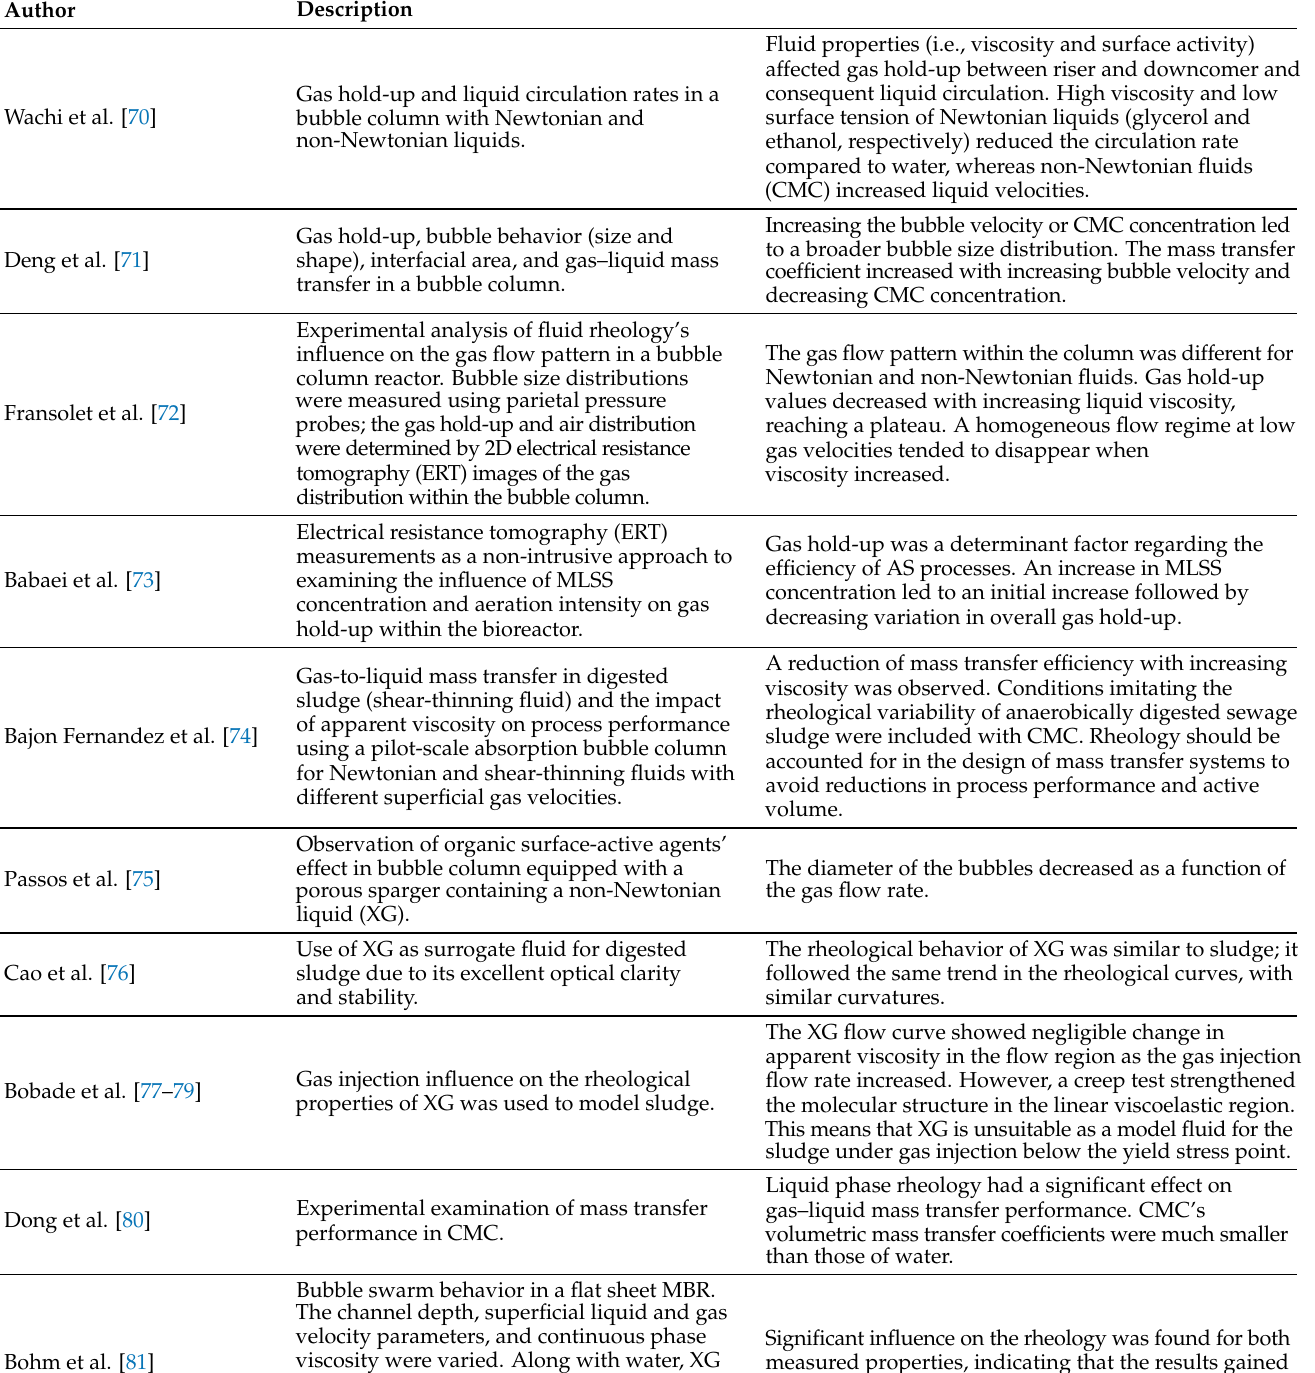
Table 3. Applications of CMC and XG in bubble